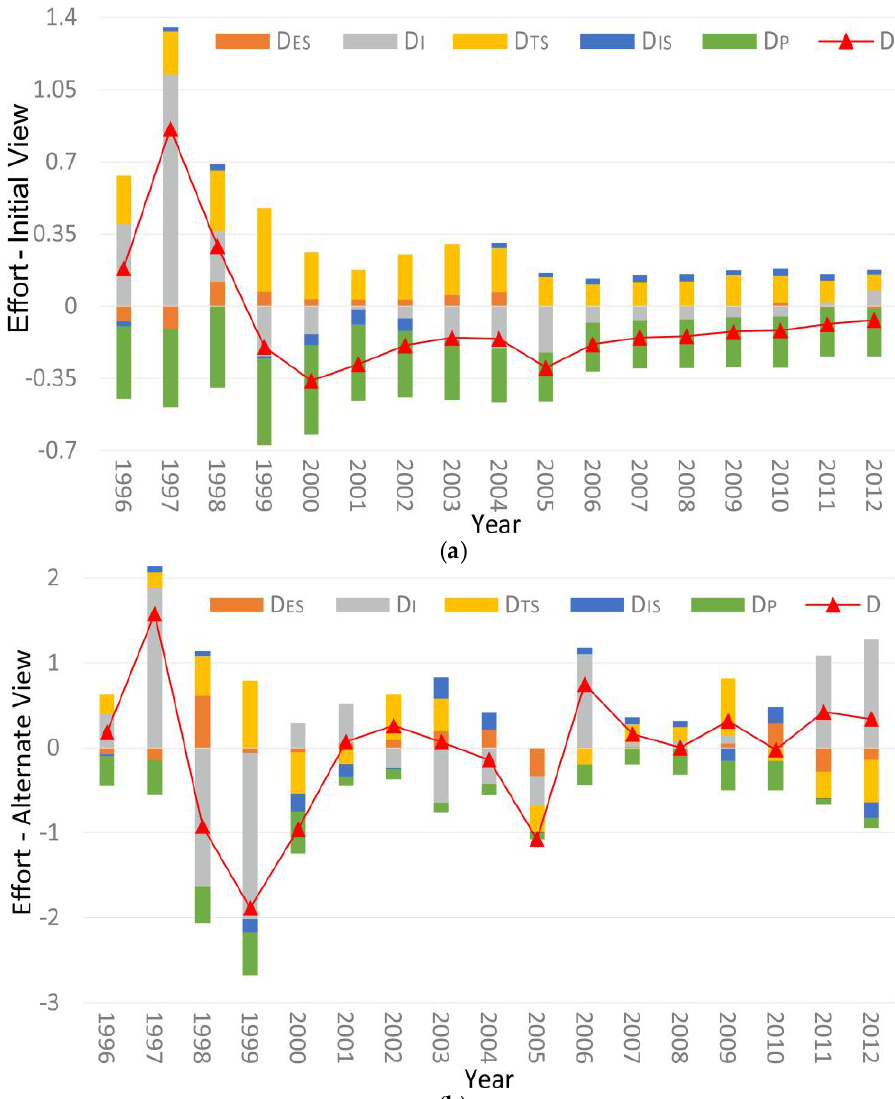
Figure 5. Decoupling effort and its components of the transport sector in Guangdong, in the initial view ( a ) and alternate view ( b ).